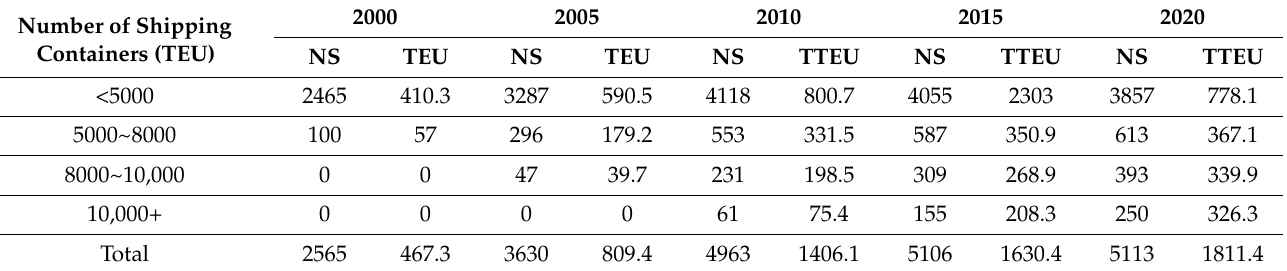
Table 1. The development status of the world’s cold chain container fleet composition.